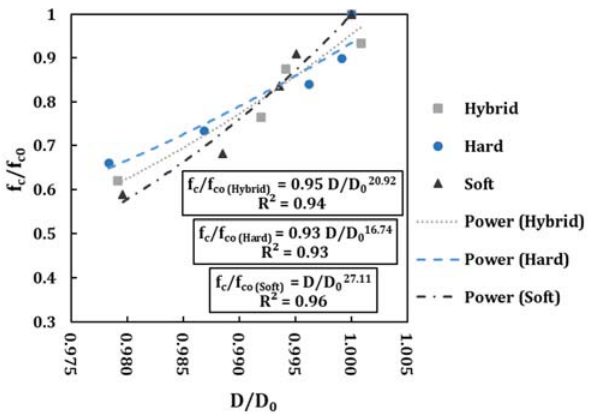
Figure 8. The compressive strength ratios versus the density ratios of BPW-containing concrete to control concrete.